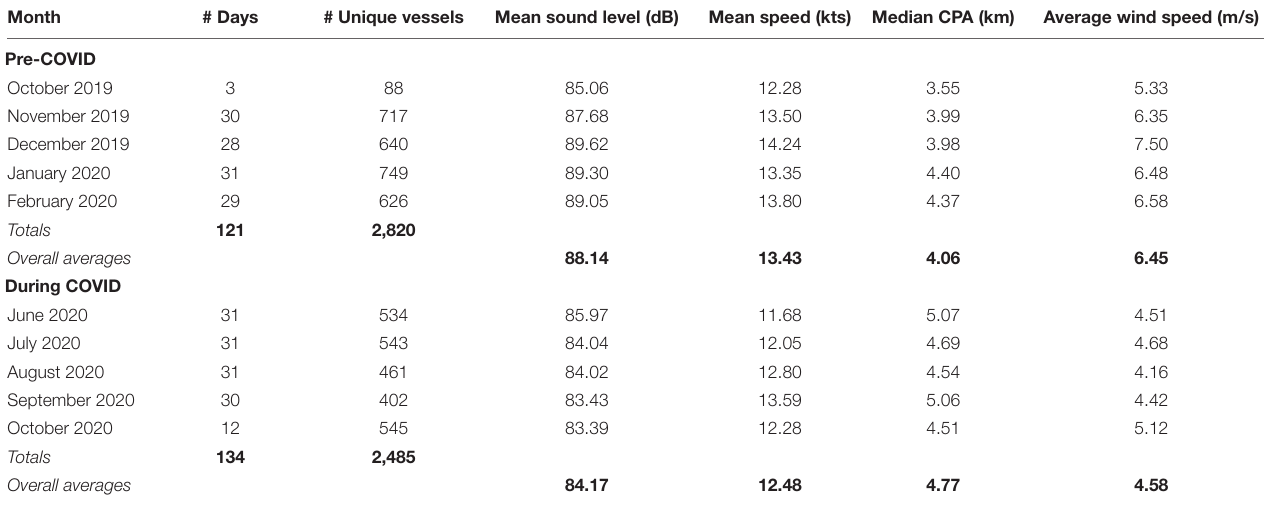
TABLE 1 | A summary of the dataset showing the number of days AIS data were recorded with corresponding hydrophone data, the number of unique vessels per month, the mean sound level detected at the acoustic recorder, the mean ship speed derived from the mean speeds for each vessel per month, the median Closest Point of Approach (CPA) of unique vessels per month and the average wind speed per